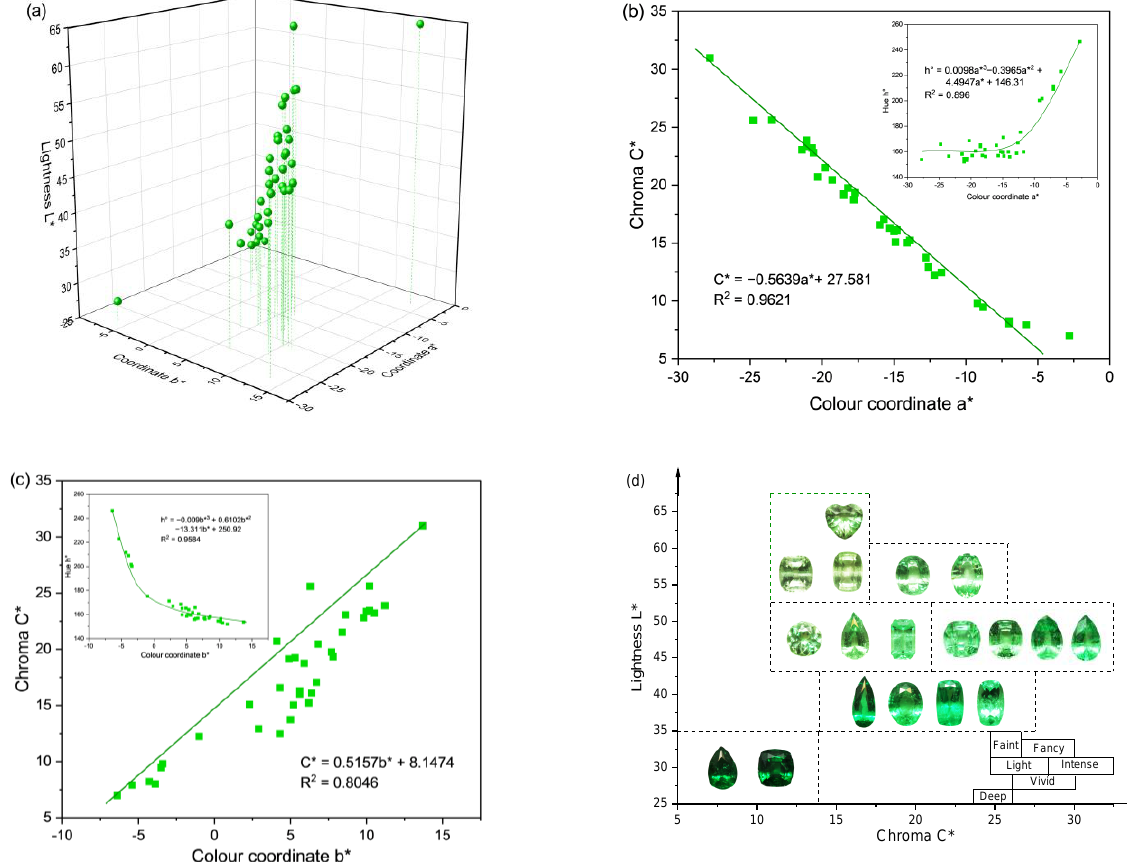
Figure 3. ( a ) 35 tsavorites plotted in CIE 1976 L*a*b*uniform color space; ( b ) correlation between color coordinate a* with chroma C* and hue h°; ( c ) correlation between color coordinate b* with chroma C* and h°; ( d ) tsavorites’ color grading is divided into: deep, vivid, intense, fancy, light, faint.